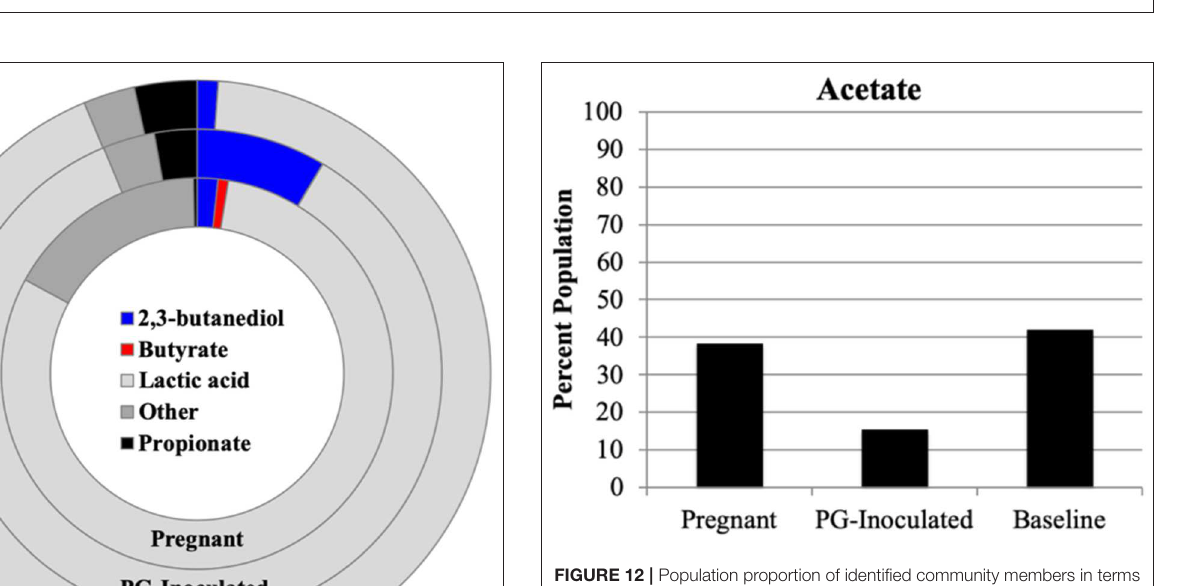
FIGURE 12 | Population proportion of identified community members in terms of predicted metabolic characteristic as a major generator of acetate for baseline, PG-inoculated, and pregnant